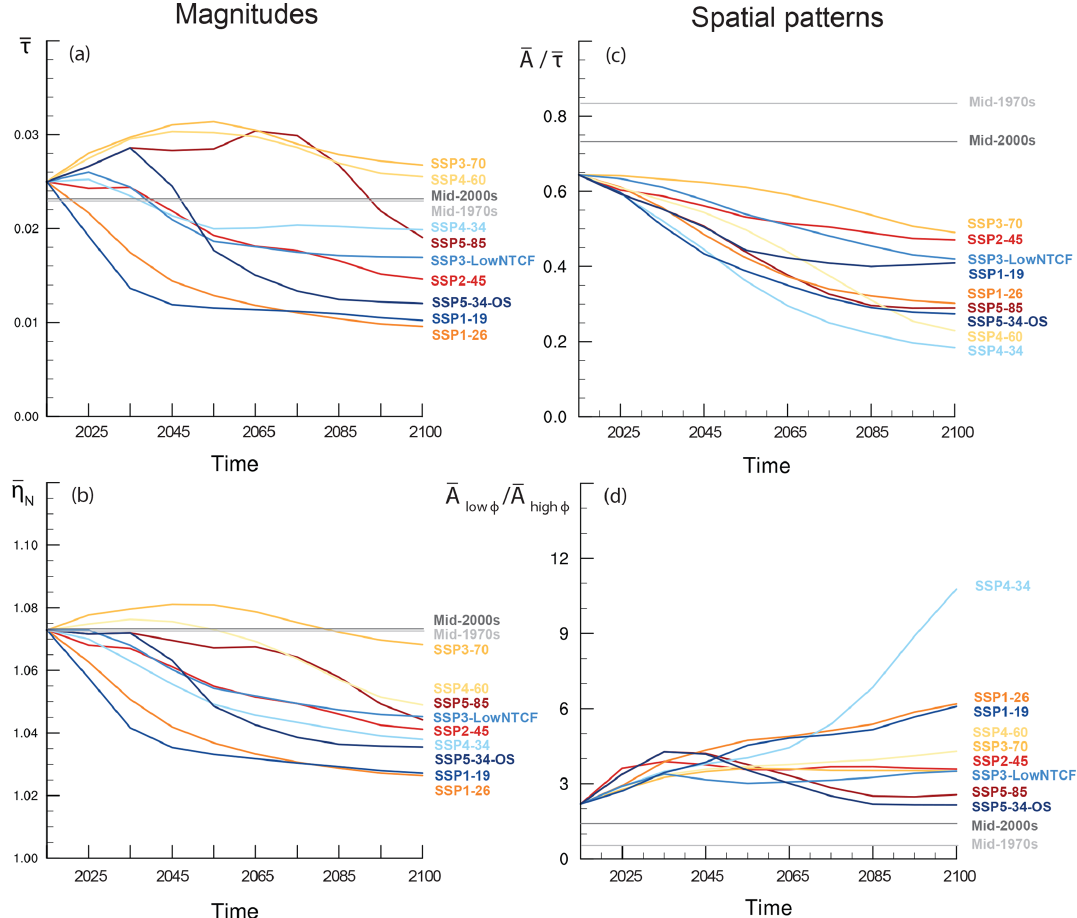
Figure 3. Future developments of global means in the MACv2-SP interpretation of CMIP6 scenarios. Shown are the temporal developments of annual averages in (a) τ at 550nm for inducing aerosol–radiation interaction and (b) η N for mimicking aerosol–cloud interaction, as well as (c) hemispheric asymmetry in τ , A , weighted by the global mean τ and (d) the ratio of A at low latitudes ( φ < 36 ◦ ) relative to higher latitudes. MACv2-SP’s ranking of the emission scenarios of CMIP6 with respect to their strength in the forcing magnitude (a, b) and the spatial asymmetry (c, d) is shown using the colour-coded labels. Reference values of the mid-1970s and mid-2000s from the historical reconstruction (Fiedler et al., 2017; Stevens et al., 2017) are indicated by the grey lines.